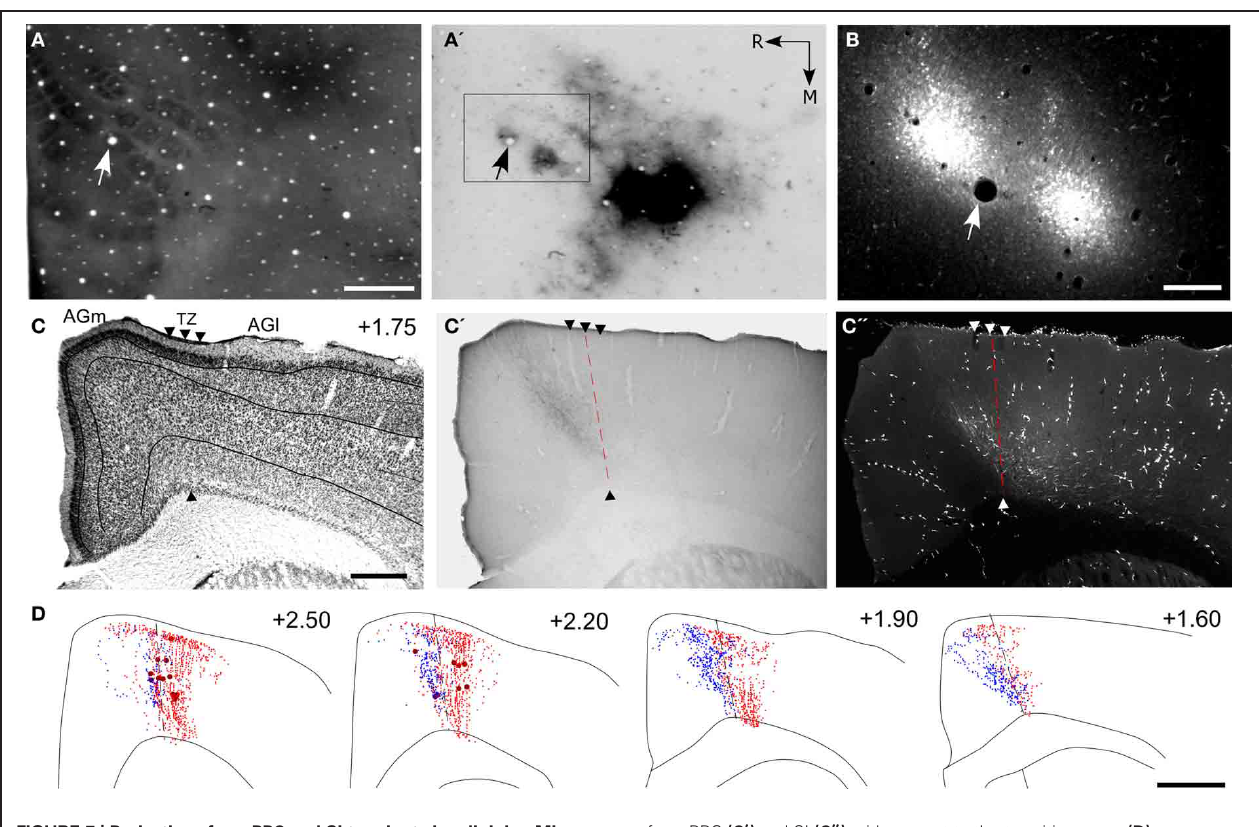
FIGURE 7 | Projections from PPC and SI terminate in adjoining MI regions. (A,A (cid:2) ,B) Tangential sections showing CO-labeled barrels and tracer injections in PPC and SI as in Figure 5 . Arrows indicate common blood vessels. (C,C (cid:2) ,C (cid:2)(cid:2) ) Adjacent coronal sections illustrate labeled projections